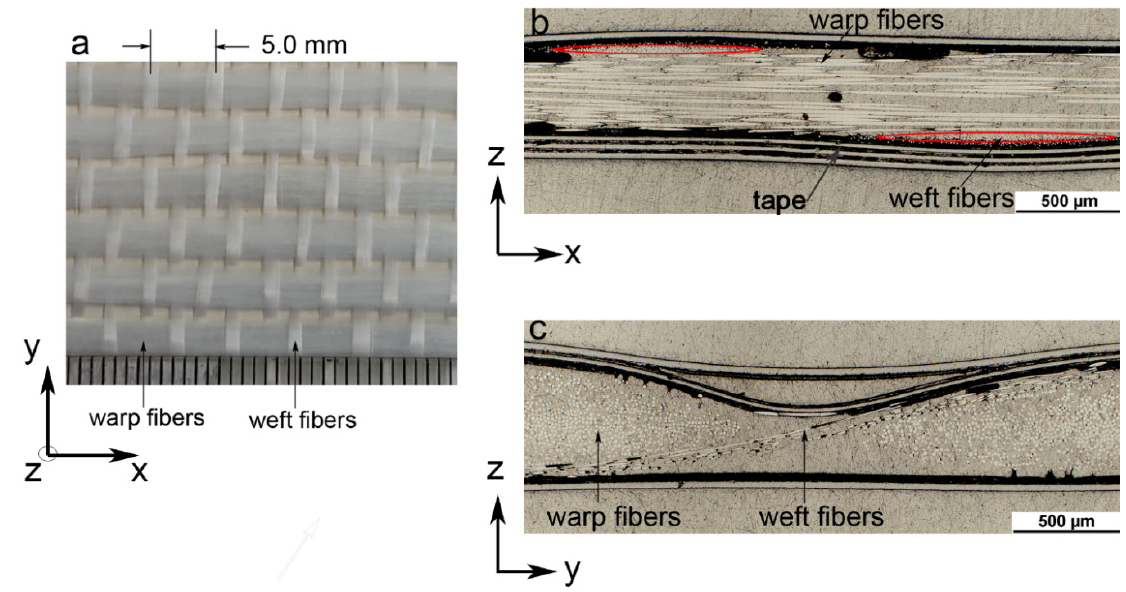
Figure 2. Quasi ‐ UD E ‐ glass fabric: ( a ) observed on the top sight (z direction), ( b ) cross ‐ section of fabric along the warp fiber direction and ( c ) cross ‐ section of fabric along the weft fiber